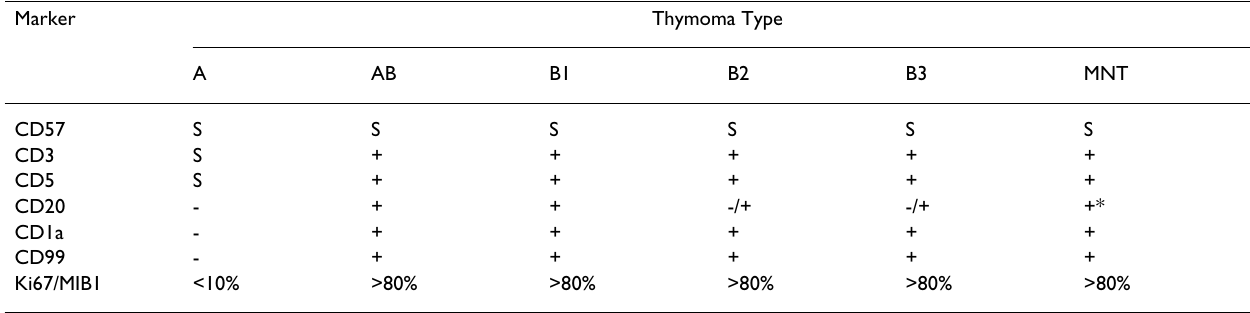
Table 4: Immunohistochemical Results, Background Lymphocytes Marker